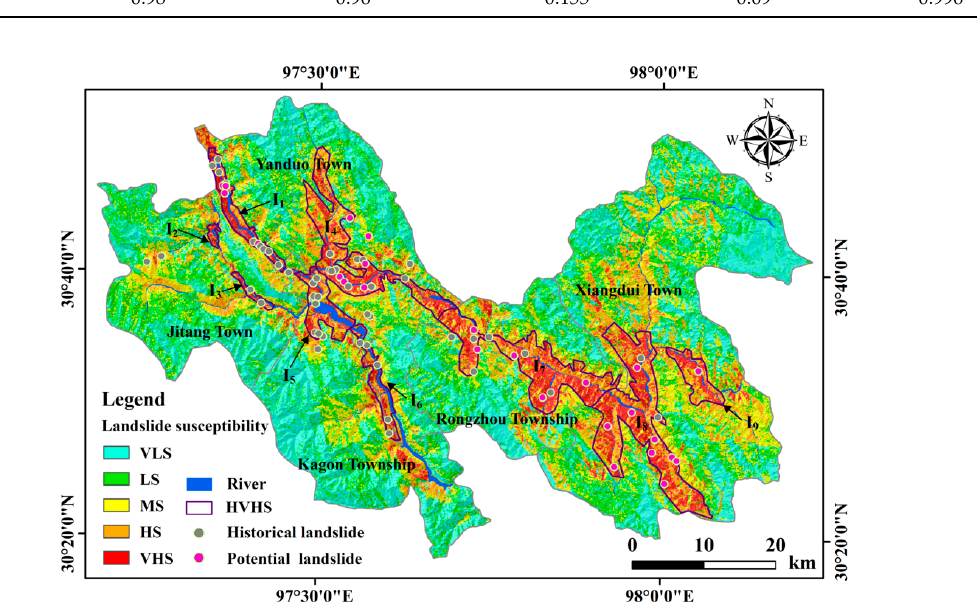
Figure 8. Landslide susceptibility evaluation map. The abbreviations include: VLS = Very low